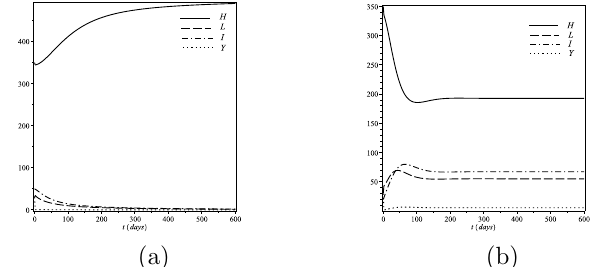
Figure 2. Simulation of system (3.1) showing the time evolution of healthy H ( t ), latent L ( t ), infected I ( t ) hosts and infected vectors Y ( t ) when (a) (cid:60) 0 < 1 and (b) (cid:60) 0 > 1. The plots show that the disease will die out if (cid:60) 0 < 1 (a) and can persist if (cid:60) 0 > 1 (b).